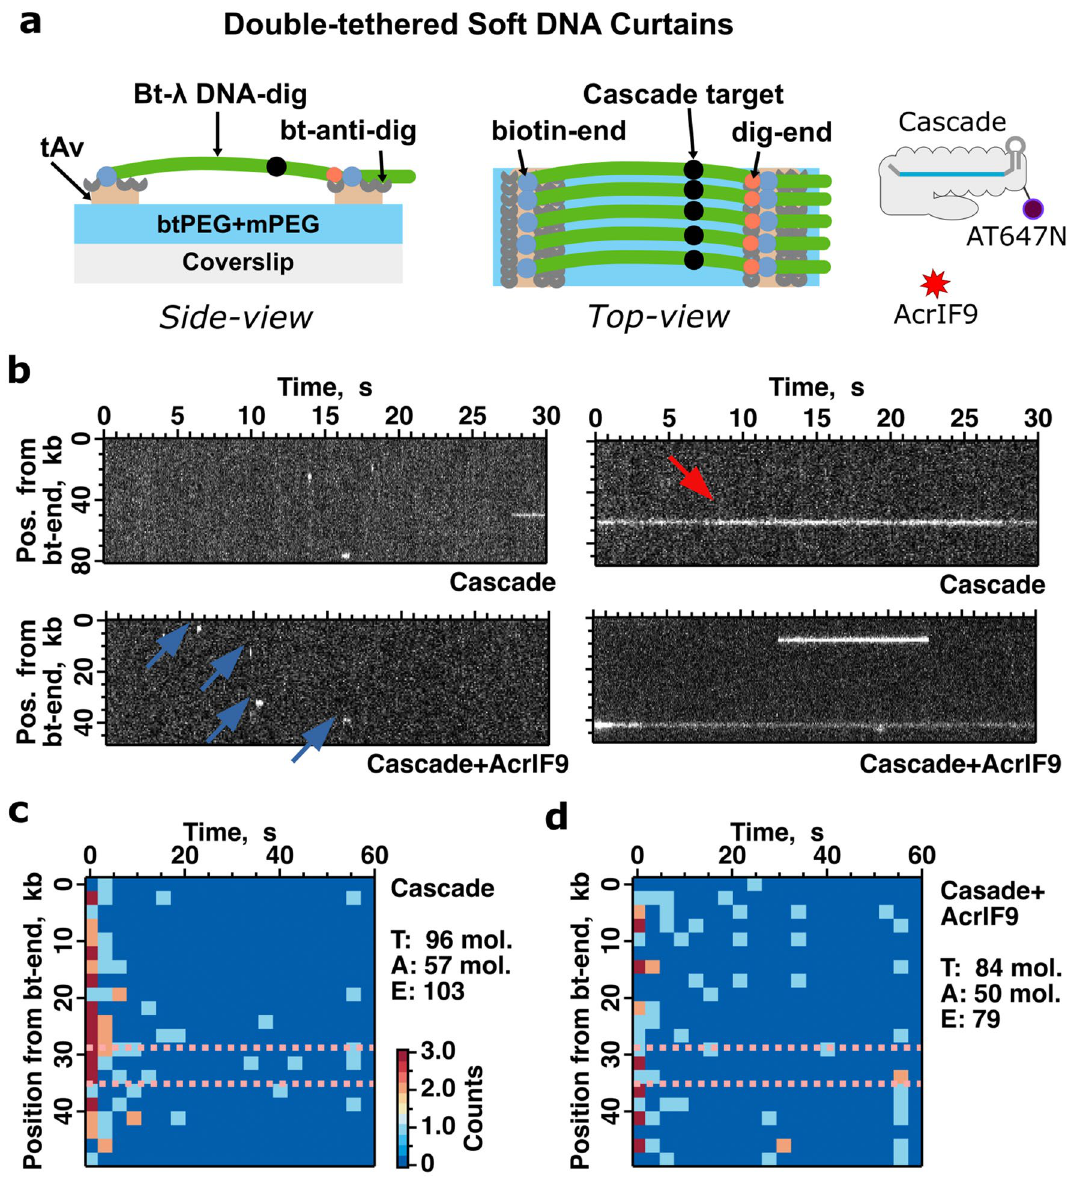
Figure 4. Binding location and duration of Cascade on the DNA Curtains. ( a ) A schematic representation of the assay depicts the double-tethered Soft DNA Curtains with the Cascade target site on λ DNA located at 31.1 kbp from the biotinylated DNA end (bt-end). Biotinylated and digoxigenin labelled λ DNA (bt-λ DNA-dig) was immobilized on the surface printed traptavidin (tAv) line-features. The dig-end of λ DNA was post-tethered using biotinylated anti-dig antibodies (bt-anti-dig). The binding of fluorescently labelled Cascade-mSav- AT647N to DNA was monitored in the presence or absence of AcrIF9. ( b ) Representative kymographs made from individual DNA molecules. These kymographs show short- (left; blue arrows) or longer-lasting (right; red- arrow) binding events of Cascade to the DNA molecule in the absence (top) or presence (bottom) of AcrIF9. ( c ) Cascade binding position vs. dwell time 2D histogram plot. The total number of examined DNA molecules (T) was 96, and 57 DNA molecules showed at least one Cascade binding event (A). The plot represents 103 individual Cascade binding events (E). The colour-code represents the binding counts. ( d ) Cascade pre- incubated with AcrIF9 binding position vs. dwell time 2D histogram plot. The total number of examined DNA molecules was 84, and 50 DNA molecules showed at least one Cascade binding event. The plot represents 79 individual Cascade binding events. The expected range of Cascade targeted binding is marked by the magenta dashed